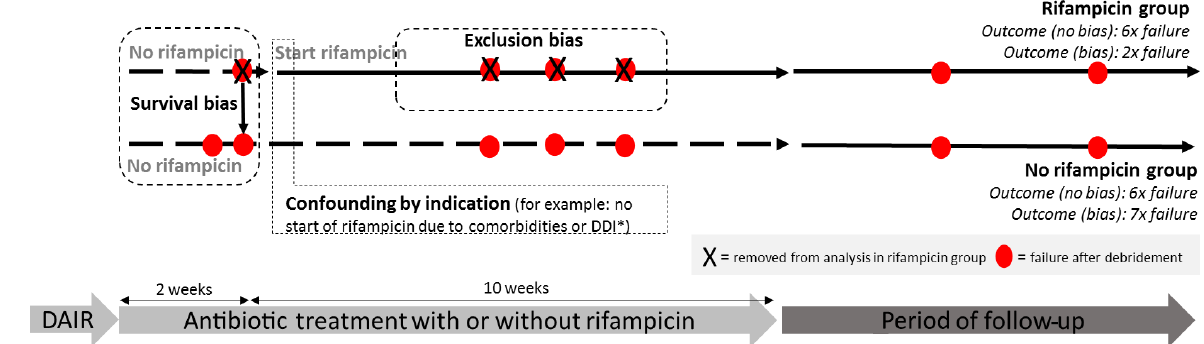
Figure 1. Hypothetical example of a prosthetic joint infection (PJI) study with a flawed outcome induced by methodological errors. Example of a PJI cohort, retrospectively stratified by use of rifampin. Survival bias occurs because only patients that “survive” the first weeks until the start with rifampin are analyzed in the rifampin group. All failures before start of rifampin will be analyzed in the non-rifampin group. Confounding by indication occurs when patients with certain risk factors for failure (e.g., comorbidities, drug–drug interactions, severely ill) are not selected for treatment with rifampin. Exclusion bias occurs if patients are excluded while they are still using rifampin, as only failures within the rifampin group can be excluded. In this hypothetical example assuming comparable treatment strategies, both groups would have an identical failure rate without bias (both six failures) but 3 times as much failure in the non-rifampin group after introduction of bias.